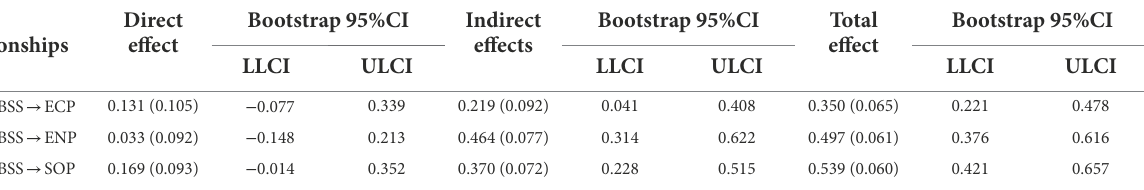
TABLE 6 Bootstrap analysis results.